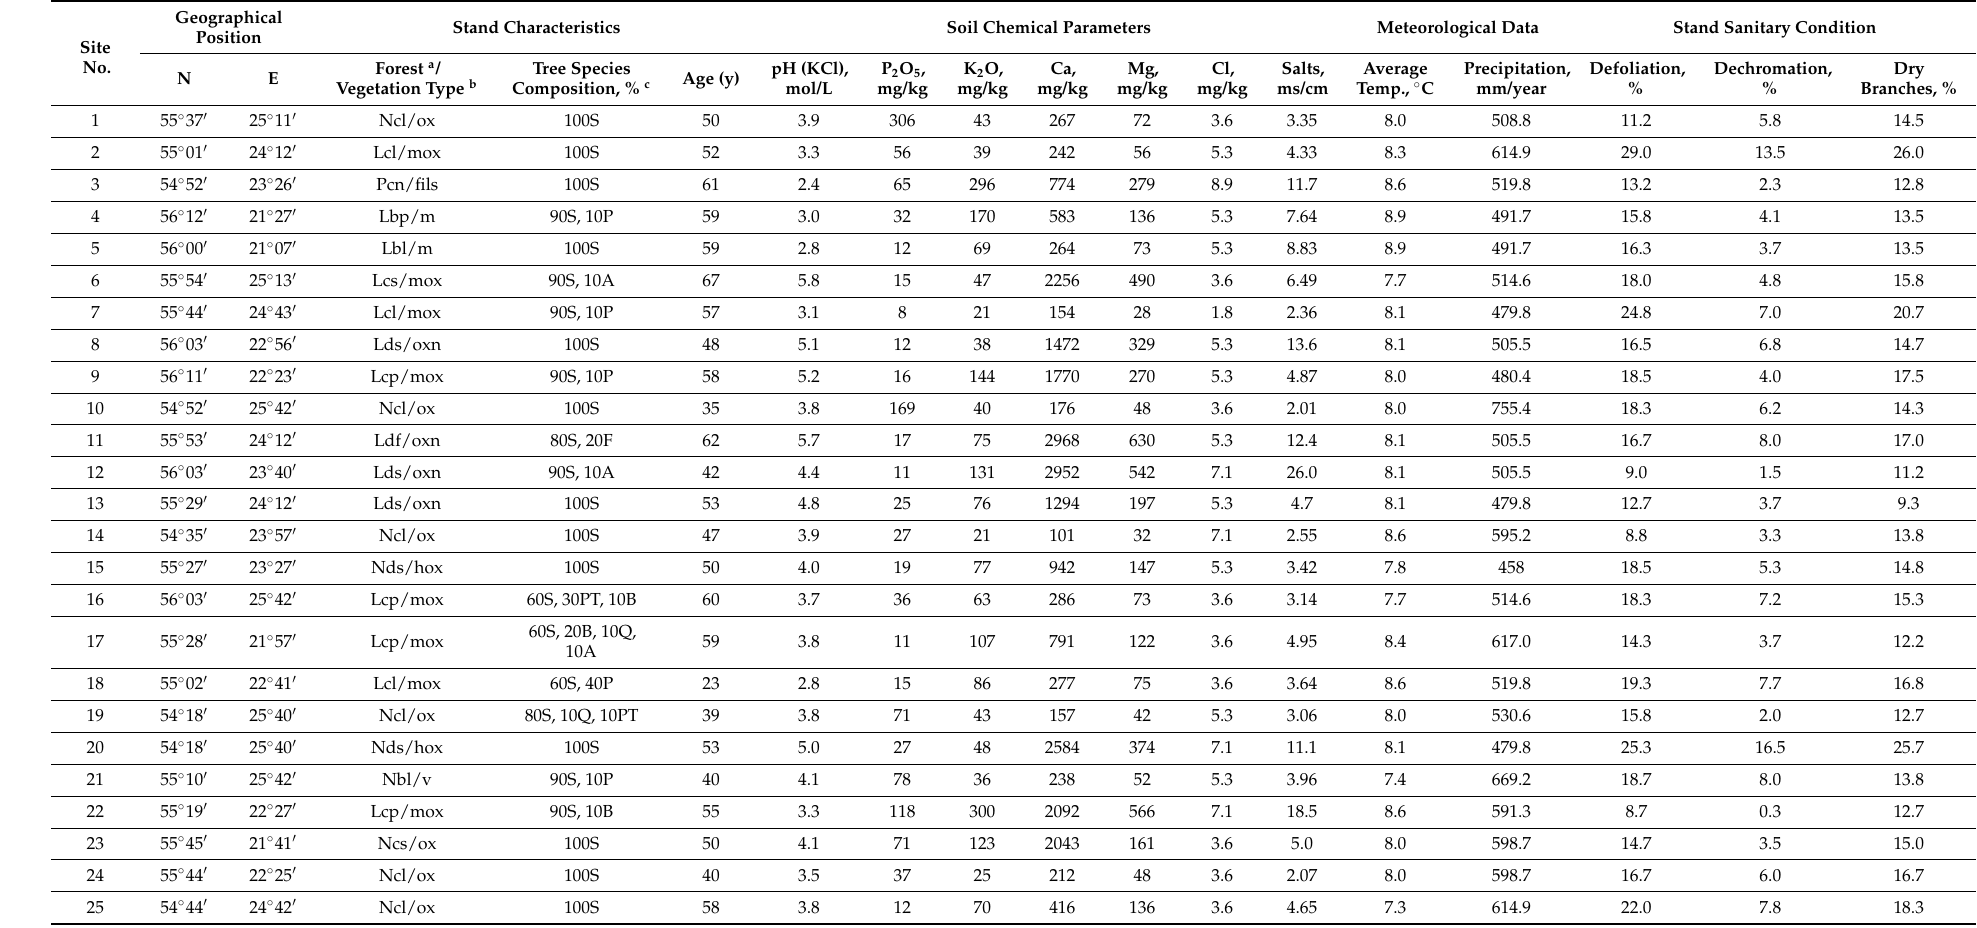
Table 1. Characteristics of Picea abies forest stands where needles, shoots, roots, and the rhizosphere soil were sampled.